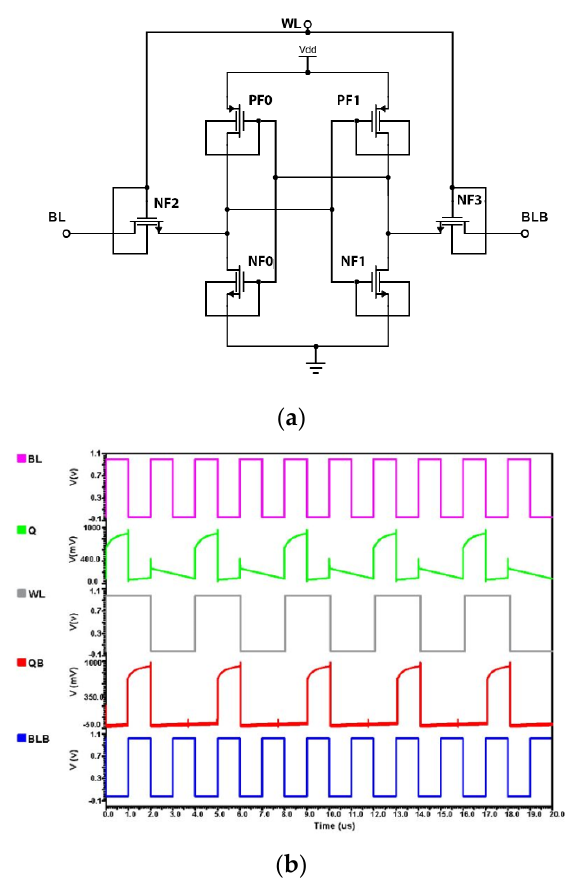
Figure 11. Silicon Substrate FinFET based 6T ‐ SRAM design ( a ) Schematic and ( b ) Transient Analysis.